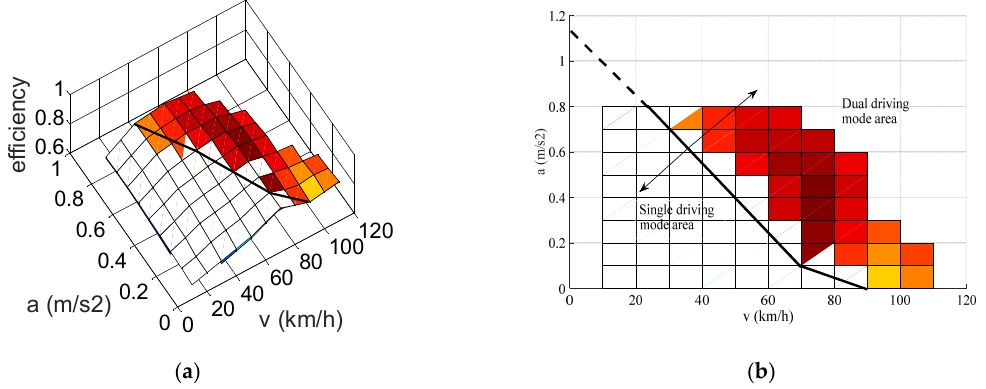
Figure 9. Efficiency comparison and switching rule under Condition 3. ( a ) Efficiency comparison under Condition 3; ( b ) Switching rule under Condition